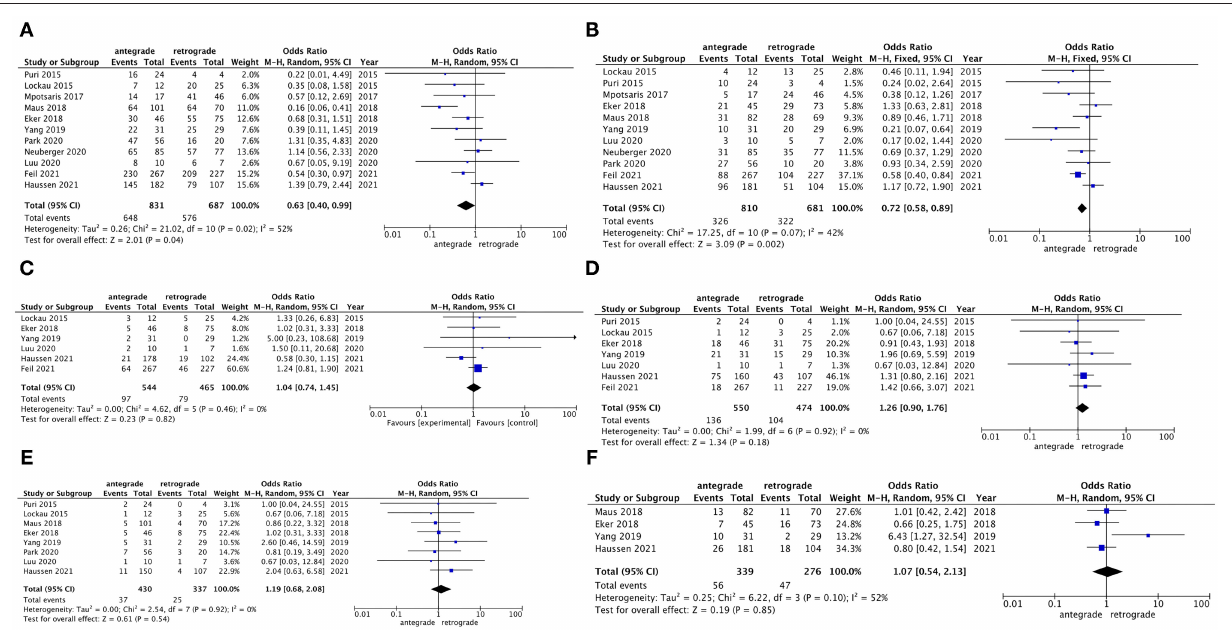
FIGURE 2 | Forest plot showing the comparison for main outcomes between the antegrade and retrograde groups. (A) successful reperfusion (TICI 2b − 3); (B) favorable outcome (90-day mRS 0–2); (C) any procedural complication; (D) any intracranial hemorrhage; (E) symptomatic intracranial hemorrhage; and (F) 90-day